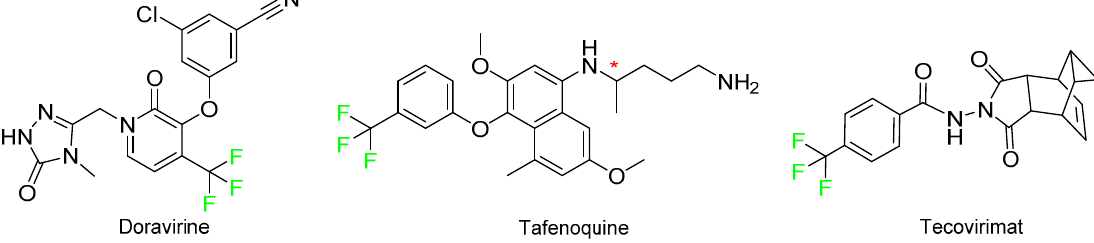
Figure 14. Structure of doravirine, tafenoquine, and tecovirimat (* denotes a chiral center).